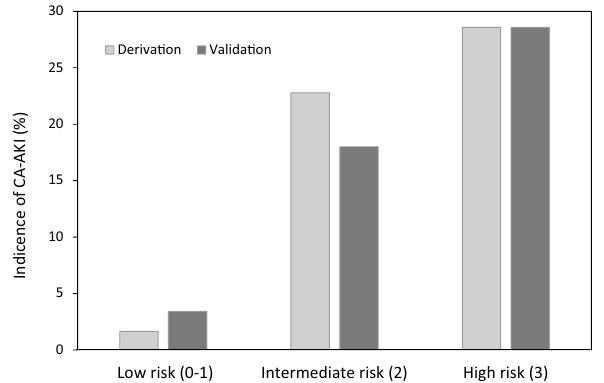
Figure 3. Incidence of CA-AKI according to the three risk groups. The incidence of CA-AKI in the derivation and validation dataset stratified into 3 groups (low risk, intermediate risk, and high risk) is shown.